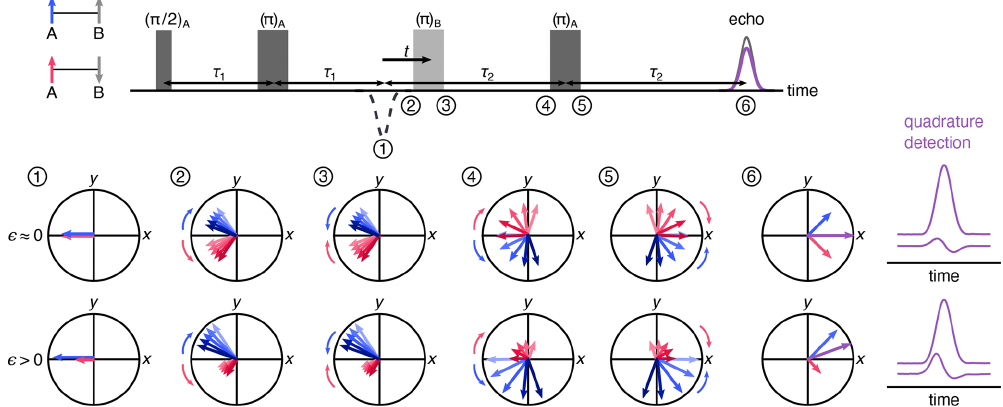
Figure 2. Vector model of the spin movement along the four-pulse DEER sequence. Cases of low- and high-polarization values are shown where the numbers indicate the vector picture at a given point in time during the pulse sequence. The vectors indicate the two sub-populations of A spins where those next to up B spins are colored blue and those next to down B spins are pink. The length of the arrows indicates the population. The overall magnetization is a sum of the two sub-populations, shown in purple. The respective echoes for low and high spin polarization values are shown on the